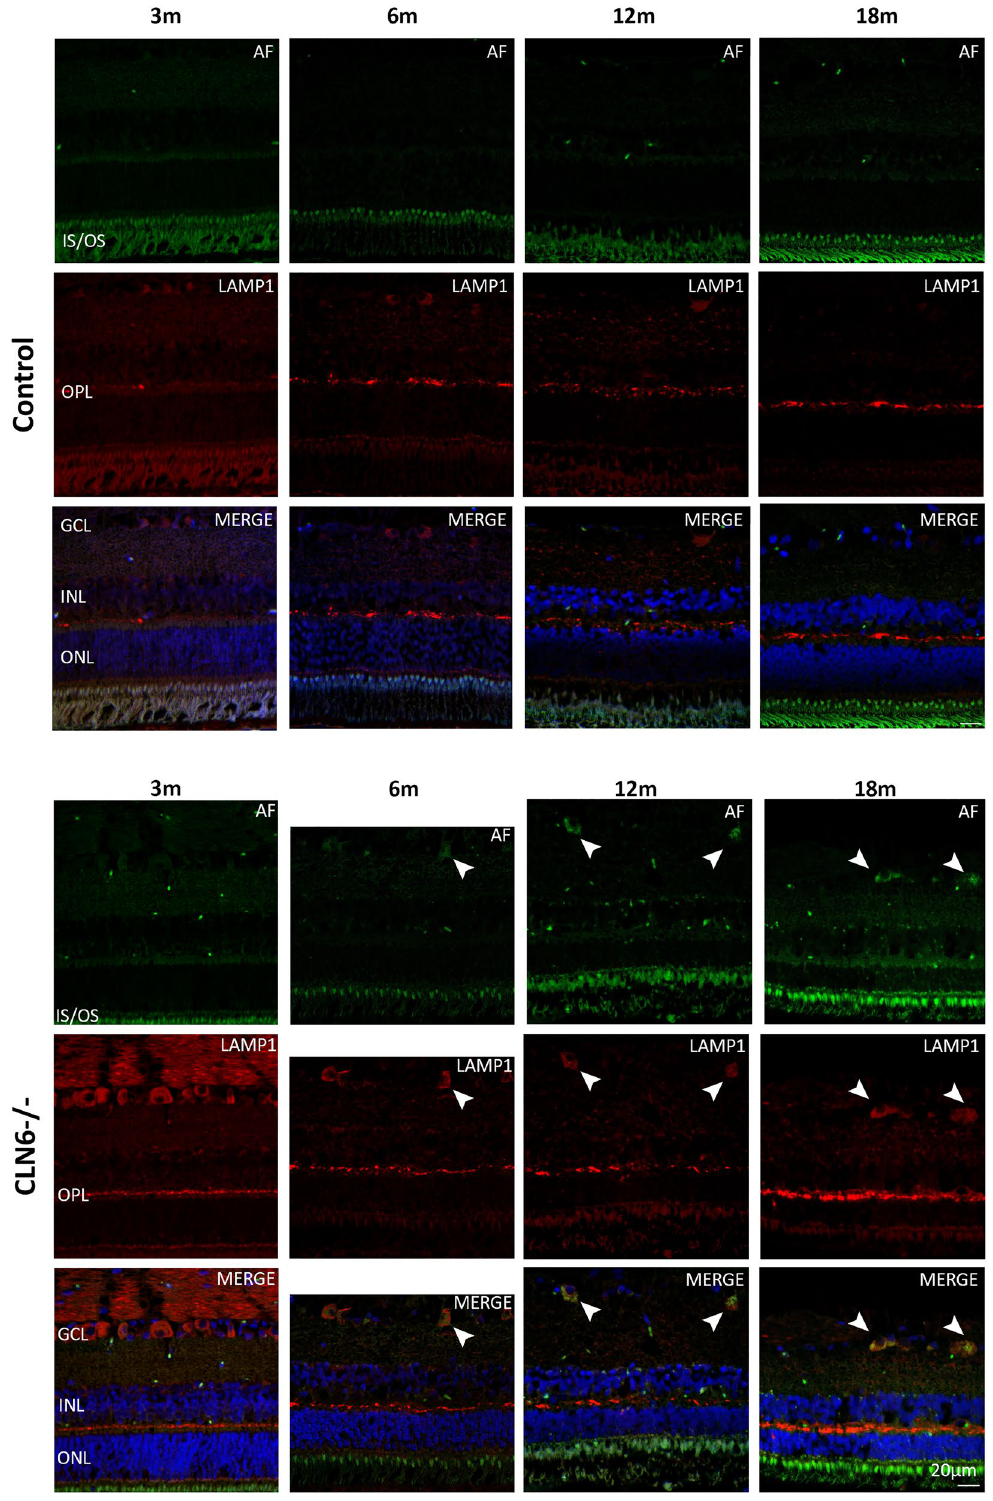
Figure 7. Lysosomal storage burden in the retina of healthy control and CLN6 −/− sheep at different ages. Top panel; Representative confocal images of control central retina. Bottom panel; Representative confocal images of CLN6 −/− central retina. AF; autofluorescence (green). LAMP1; lysosomal-associated membrane protein 1 (red). Merged image shows AF and LAMP1 with DAPI nuclei stain (blue). Arrowheads highlight co-localisation of AF and LAMP1, indicating lysosomal storage in the CLN6 −/− retina at 12 and 18 months of age. GCL; ganglion cell layer, INL; inner nuclear layer, OPL; outer plexiform layer, ONL; outer nuclear layer, IS/OS; inner and outer segments of photoreceptors. Scale bar 20